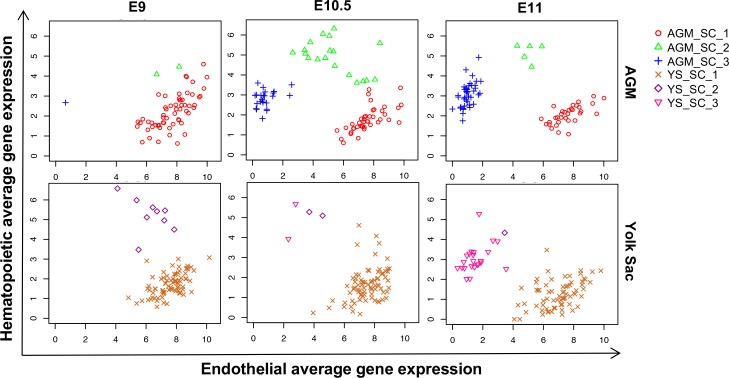
Time-course analysis of EHT in the AGM and YS.Scatter plots showing the average expression of endothelial genes versus the average expression of hematopoietic genes at the indicated developmental time points.See also Supplementary file 11.